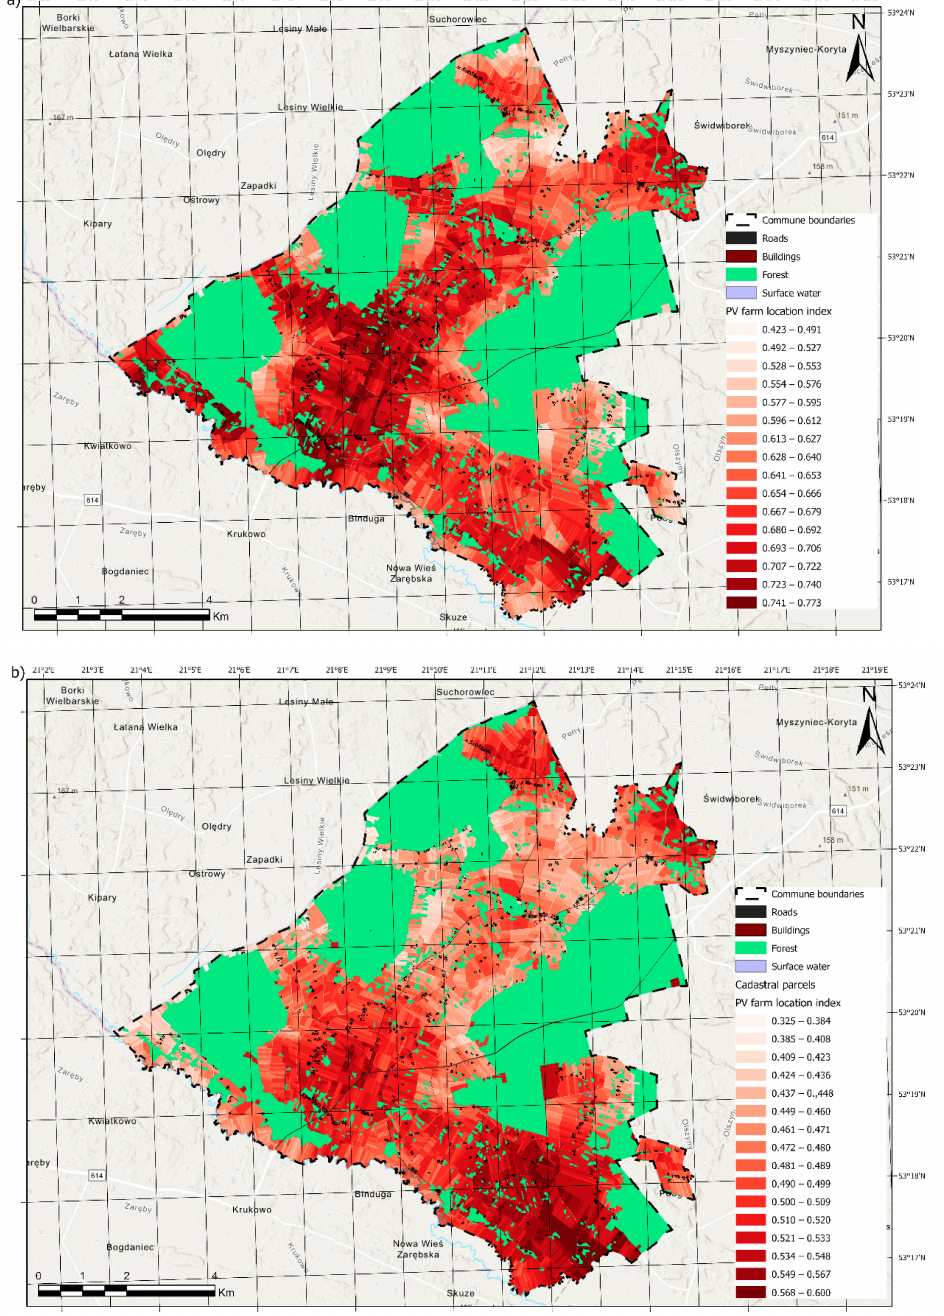
Figure 14. A comparison of the values of the optimum PV farm location index using: ( a ) the AHP method, and ( b )